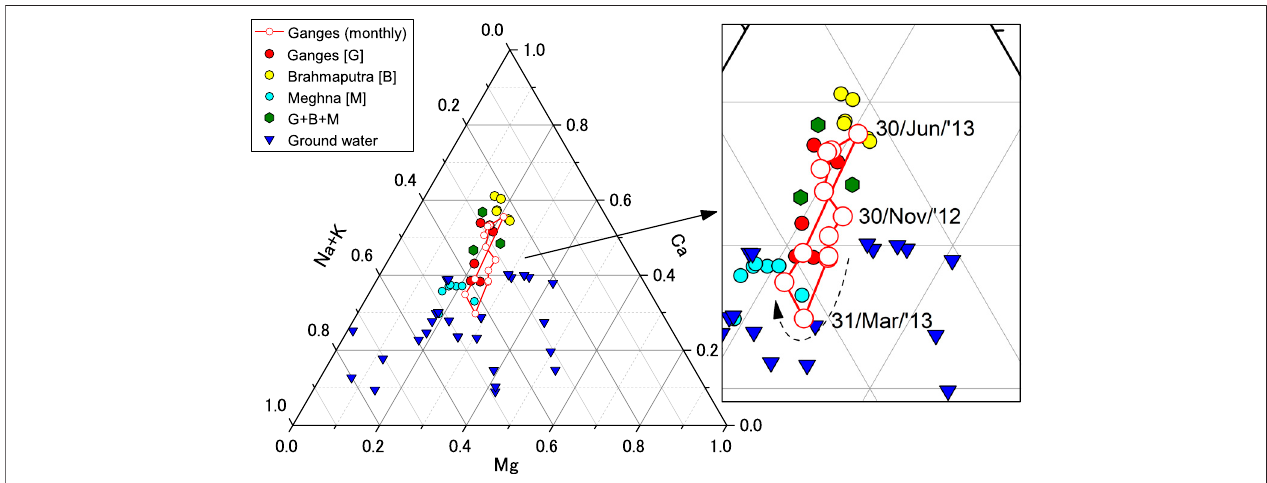
FIGURE 5 | Ternary diagram showing the relative proportion of major cations for monthly river water and groundwater samples alongside previously published values(Manaka et al.,2017;Manaka et al.,2019;Yoshimuraetal.,2021).Ared open symbol withalinerepresentstheGangesRiver ’ smonthlywatersamplesatPakshi from October 2012 to August 2013. “ G + B + M ” indicates the sample from the lower Meghna River, below its con fl uence with the Ganges – Brahmaputra river